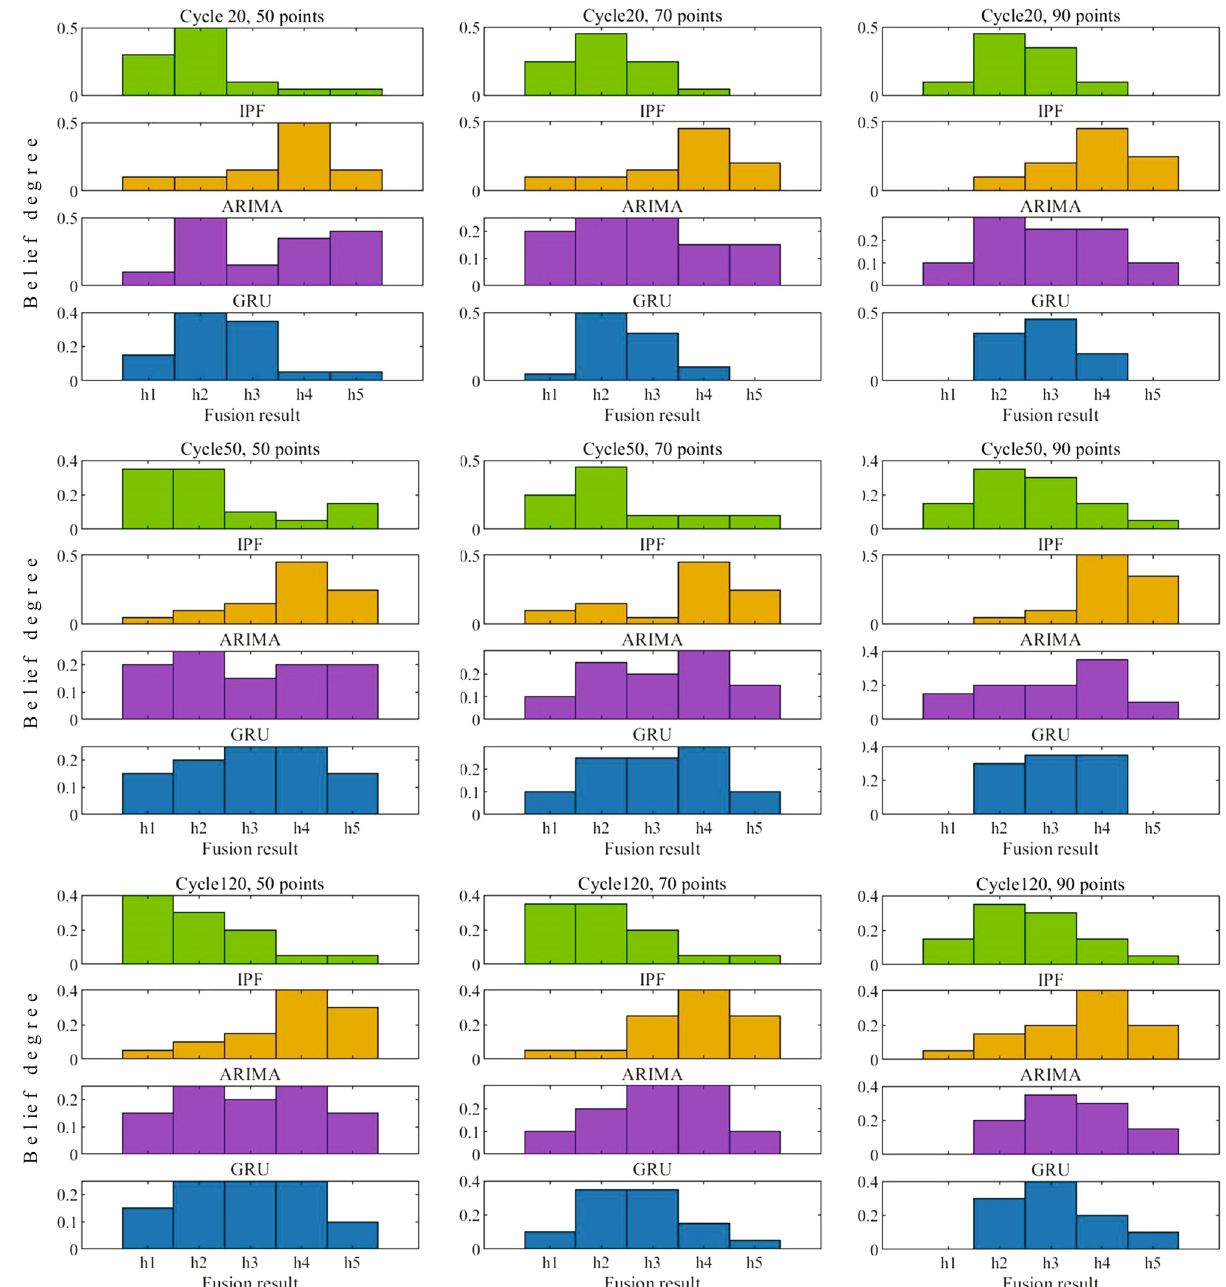
Figure 5: Belief degree distribution of each prediction